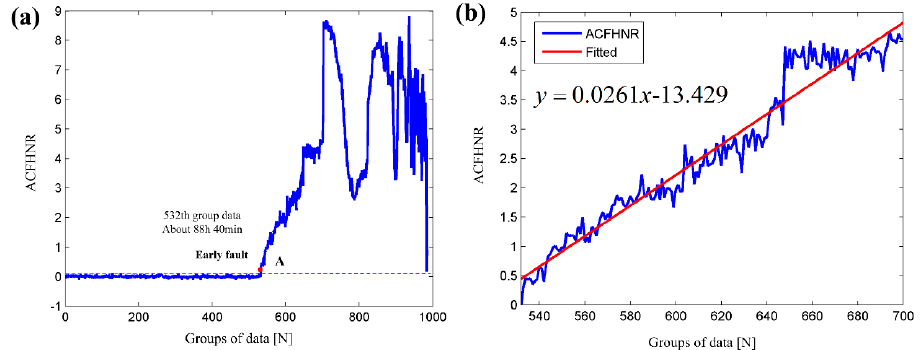
Figure 17. ( a ) The ACFHNR value for the full life cycle of bearing 1; ( b ) The sensitivity value of ACFHNR.